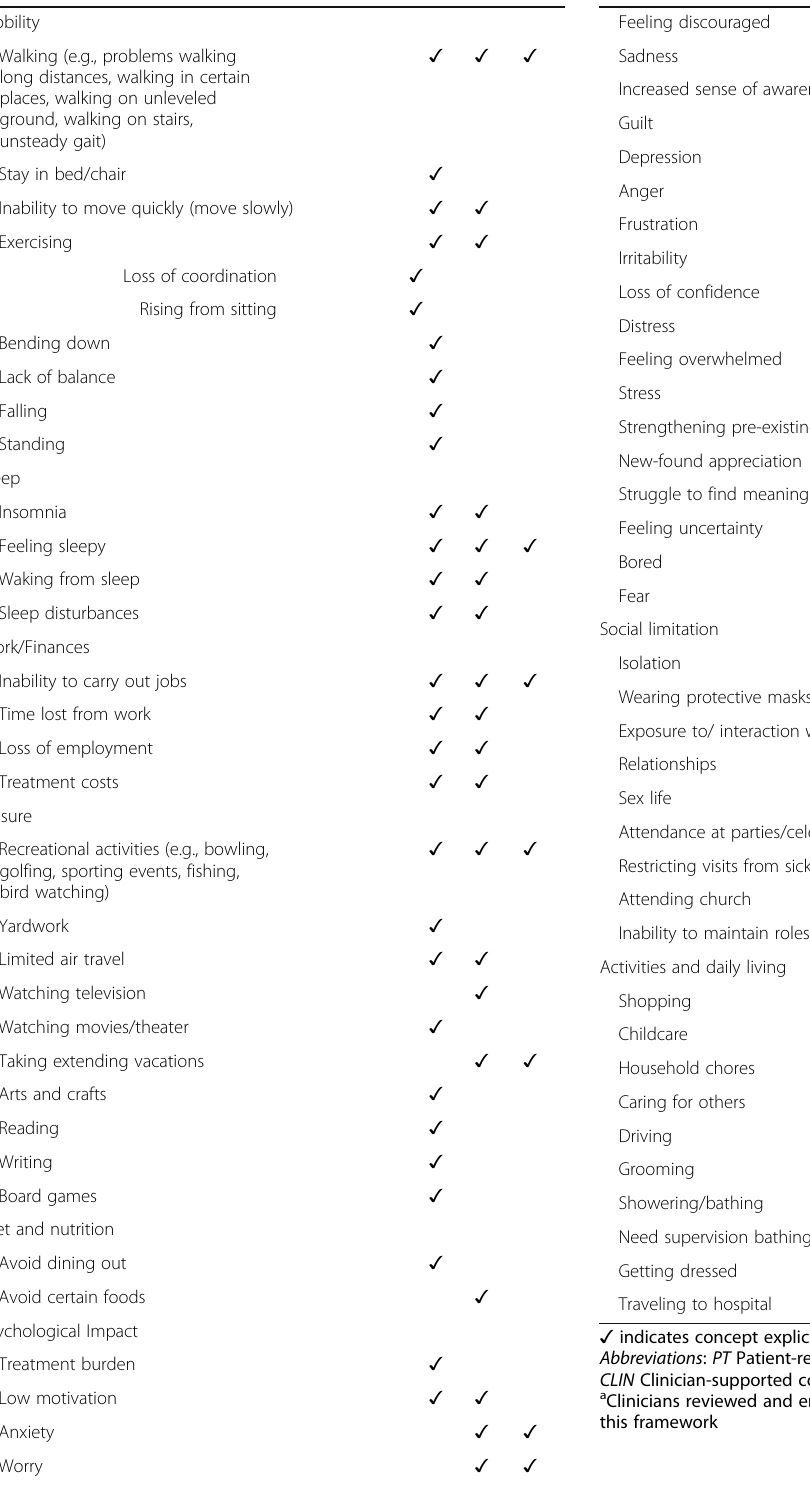
Table 3 Consolidated impact conceptualization of patient experience with MDS, AML and CMML